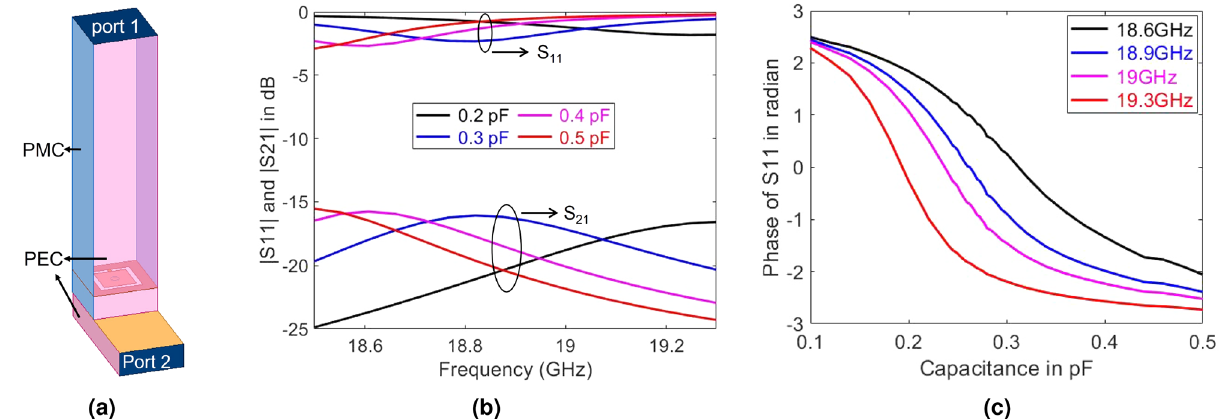
Figure 2. ( a ) The schematic of the setup used for simulating a single hybrid meta-atom. PEC and PMC refer respectively to perfect electric conductor and perfect magnetic conductor. ( b ) Simulated reflection, | S 11 | , and coupling, | S 21 | , coefficients as a function of frequency. ( c ) Phase of S 11 vs. capacitance at several frequencies for a meta-atom with integrated sensing